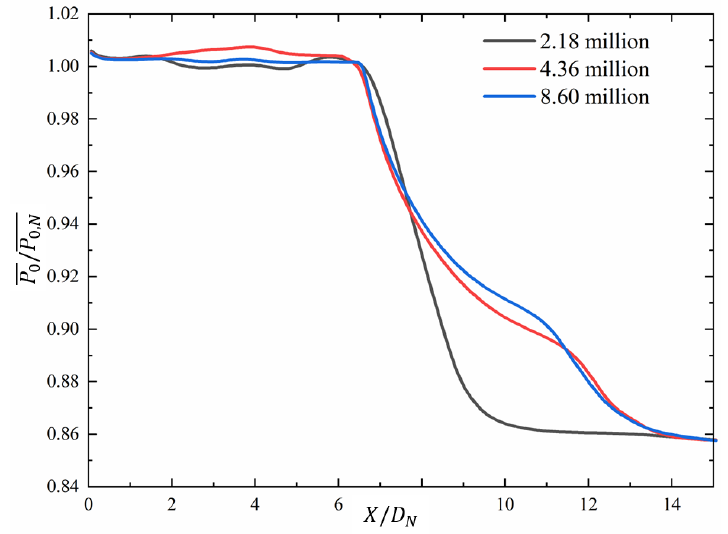
Figure 4. Grid Figure 4. Grid independence.